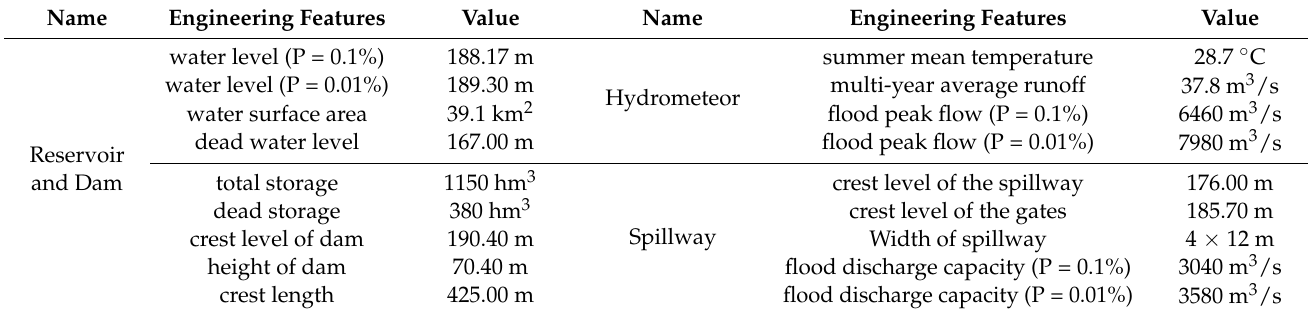
Figure 1. Location of the Chengbi River Reservoir. Table 1. Engineering characteristics of the Chengbi River Reservoir.